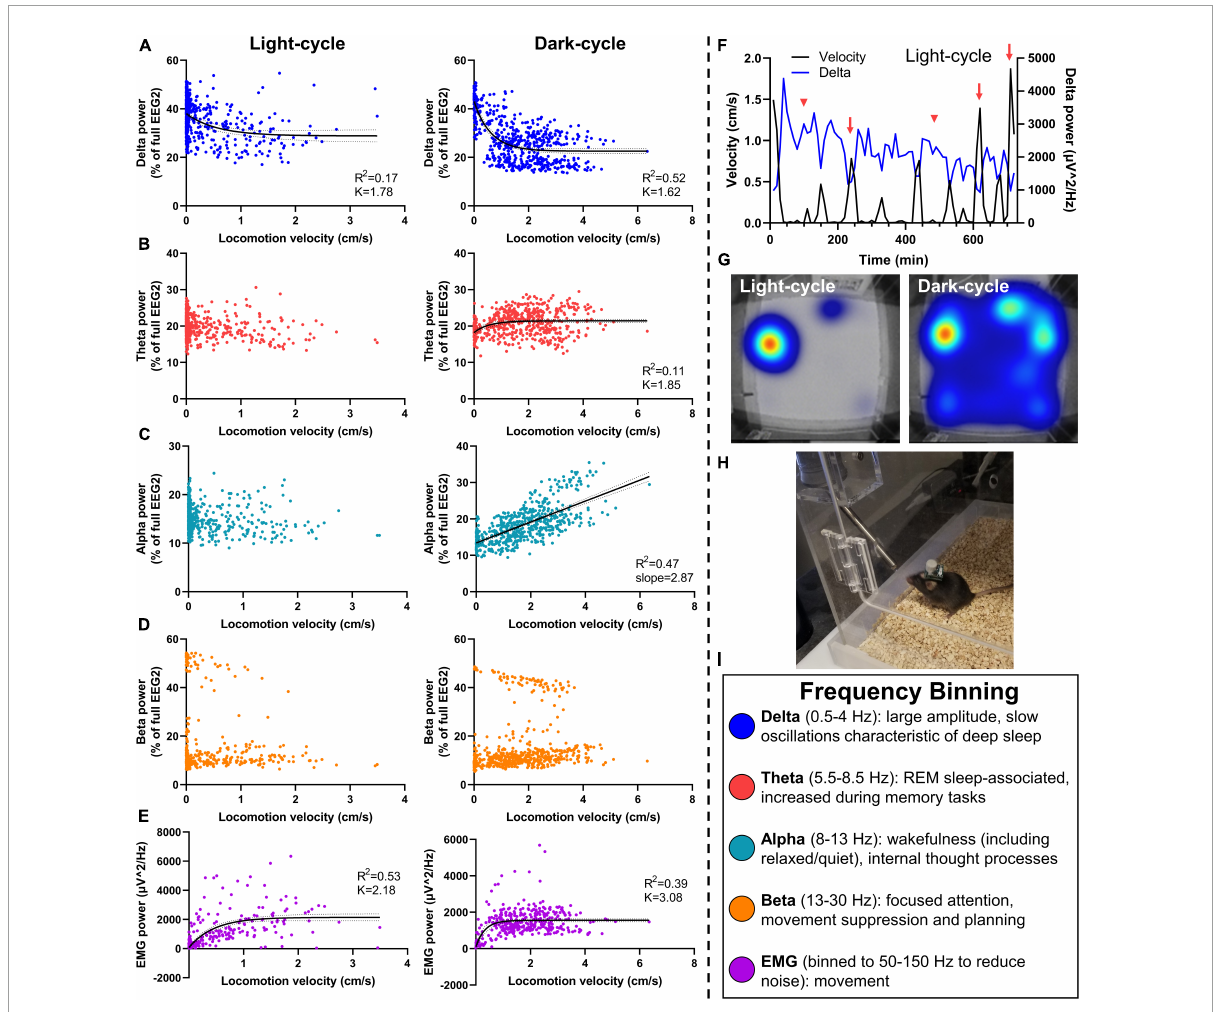
FIGURE4 Relationship of neuronal frequency with locomotor activity. Mice were assessed in PhenoTypers with concurrent EEG/EMG recordings over 24 h in the light and dark cycles. Velocity was aligned with relative EEG frequency bands (normalized to full power) in 10-min bins to assess relationships between locomotion and sleep behavior with neuronal power. (A) Delta power was negatively associated with movement in light and dark cycles, demonstrating notably high delta during low-velocity recordings indicative of NREM and slow wave sleep, and a taper from delta power with high locomotion. (B) Theta power demonstrated a slight relationship in the dark cycle only. (C) A linear velocity × alpha relationship was detected in the dark-cycle only. (D) No velocity × beta relationships were observed. (E) EMG (50–150 Hz) exhibits a positive relationship with velocity in both light and dark cycles. (F) Light-cycle graph of velocity and delta power over time in a representative mouse demonstrates the increased delta power during sleep bouts (red arrowheads), and decreased delta power during movement (red arrows). (G) PhenoTyper heatmap of movement in the light and dark cycle. (H) Mice with EEG/EMG headcap and potentiostat exhibit normal exploratory and locomotor behavior in PhenoTyper (refer to Supplementary Figure 3A ). (I) EEG frequency bins are listed with relationships to behavior. Data are 10-min bins of power and locomotor activity, with the line of best fit ± 95% CIs, from n = 8 mice (A–D) or n = 6 mice (E) . Linear and non-linear regression (exponential one-phase decay, least squares